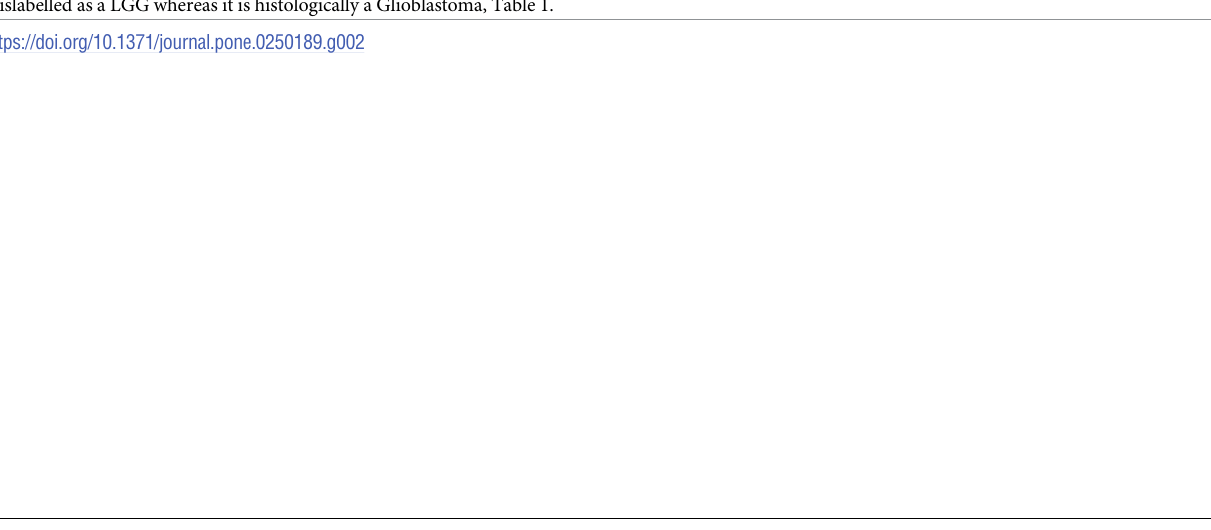
PLOS ONE | https://doi.org/10.1371/journal.pone.0250189 April 8, 2021 3 /